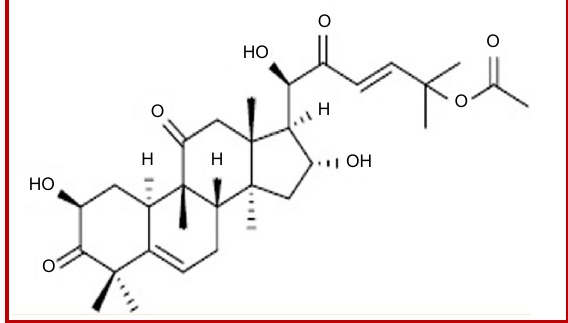
Figure 1: Structure of cucurbitacin